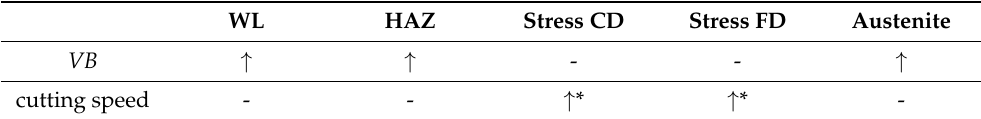
Table 6. Influence of VB and cutting speed on residual stresses, austenite fraction, and WL and HAZ thickness.